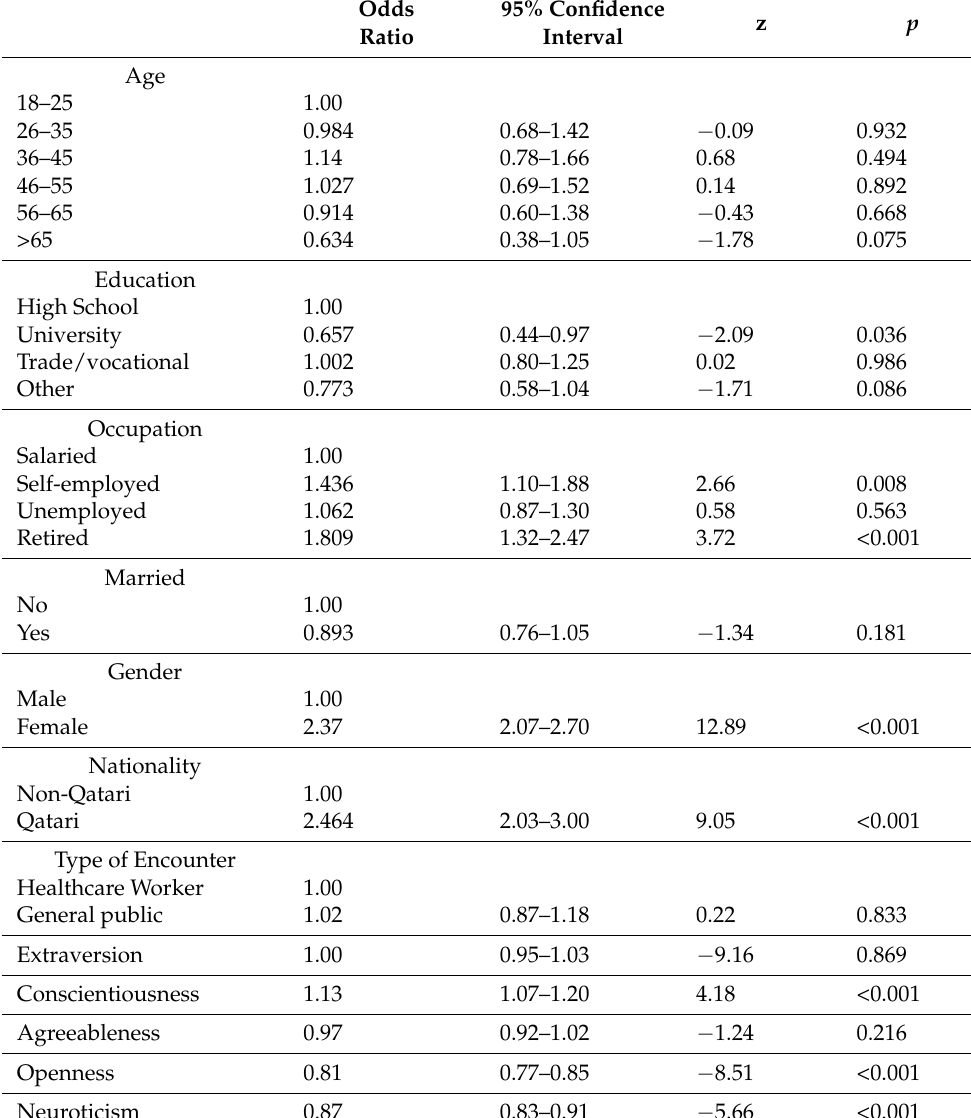
Table 3. Multivariable logistic regression model of the relationship between vaccine hesitators and Big-five personality traits and demographic